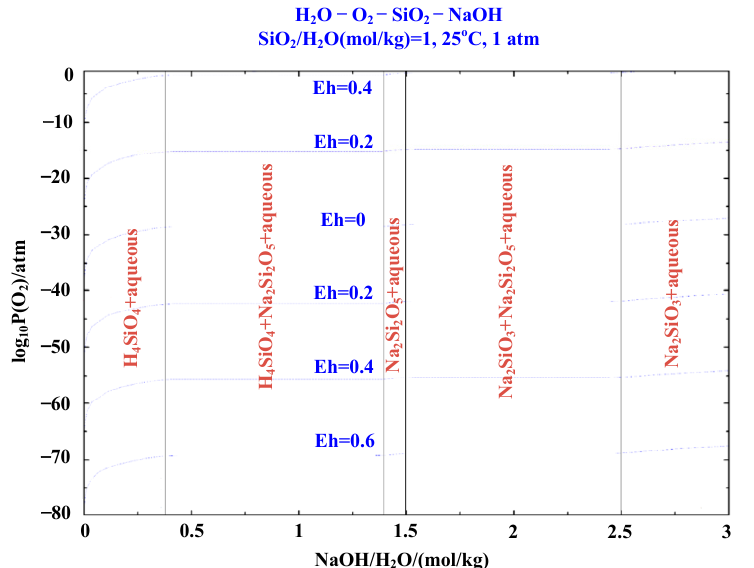
Figure 8. Predominance diagram of SiO 2 alkali leaching.